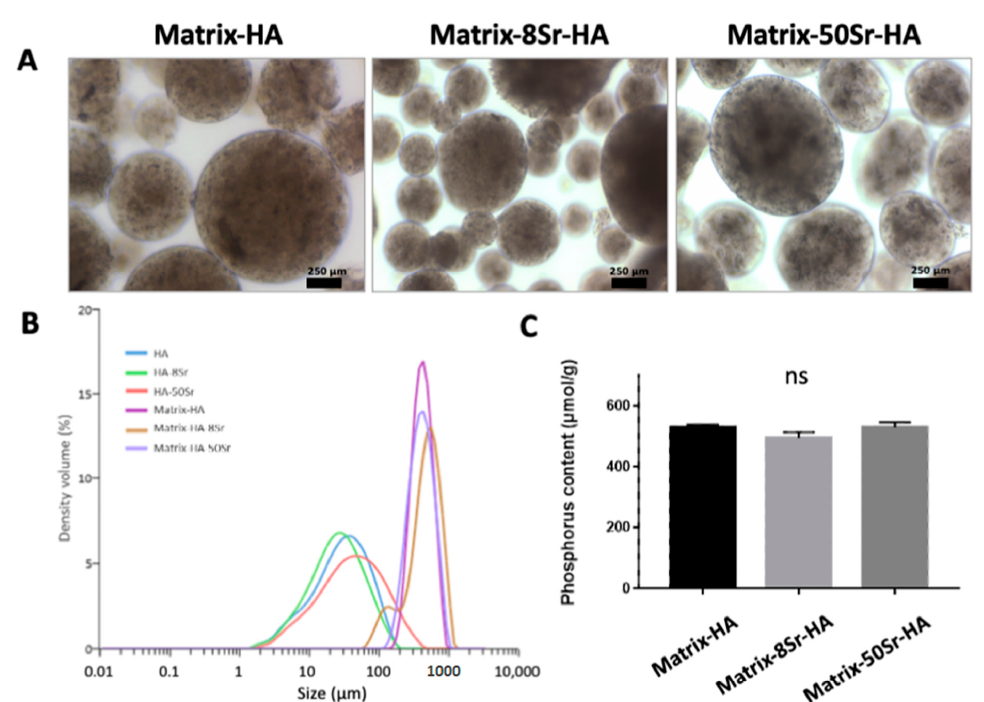
Figure 2. Characterization of the microbeads doped with strontium: ( A ) Morphology of composite beads prepared using hydroxyapatite doped or not with strontium. Results were obtained after immersion of freeze-dried beads in PBS 0.1M pH 7.4. Images obtained by contrast phase microscopy (objective × 10). ( B ) Size distribution of hydroxyapatite +/ − strontium, and of composite beads prepared using the same concentration of polysaccharides, cross-linking agent (STMP), and hy- droxyapatite, doped or not with strontium. Results after immersion of freeze-dried beads in PBS 0.1M, pH 7.4, are mean values ± SD ( n = 6) obtained using a laser dynamic scattering particle size-measuring instrument. ( C ) Phosphorus content of cross-linked composite beads was determined using a colorimetric method. Results are presented as mean values ± SD ( n = 4). ns: no significant differences. Results are presented as mean values ± SD ( n = 4); ns: no significant